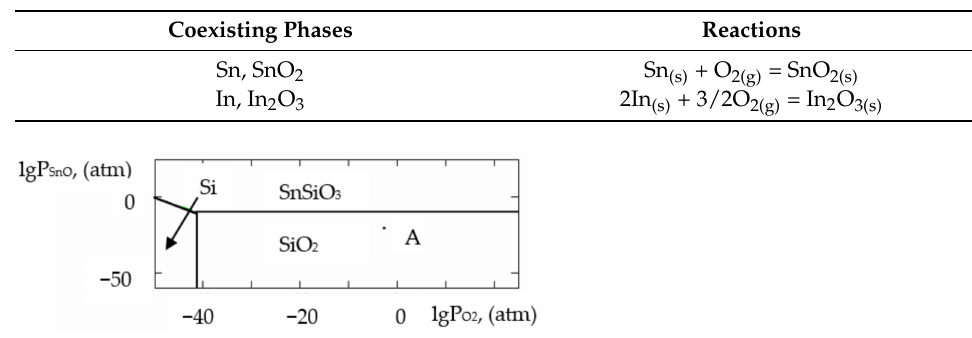
Table 5. Phase equilibriums in In–Sn–O system.